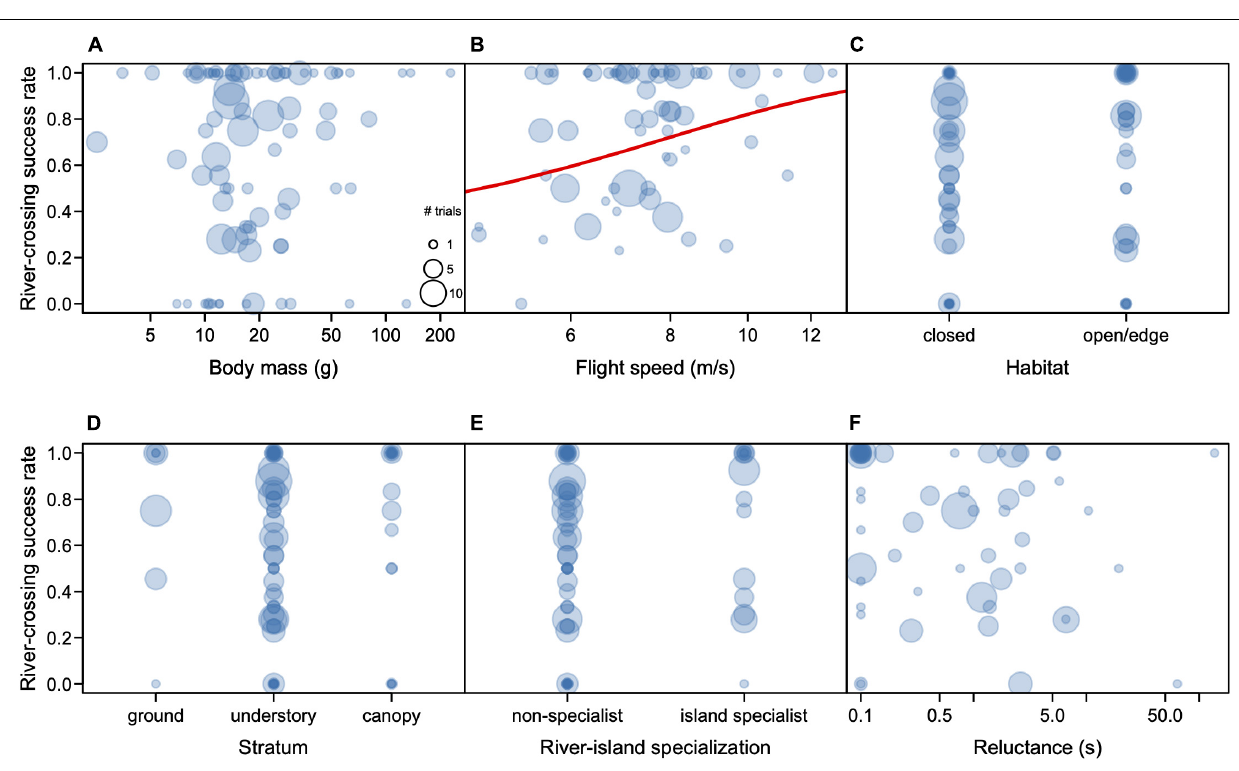
the ground (7 species), and the open airspace (1 species) ( Table 1 ). About half (42) of the species were typical of open habitats (20 species) or forest edge (22 species) and the other half (40 species) was represented by forest interior birds ( Table 1 ). At least 15 of the 84 species subjected to